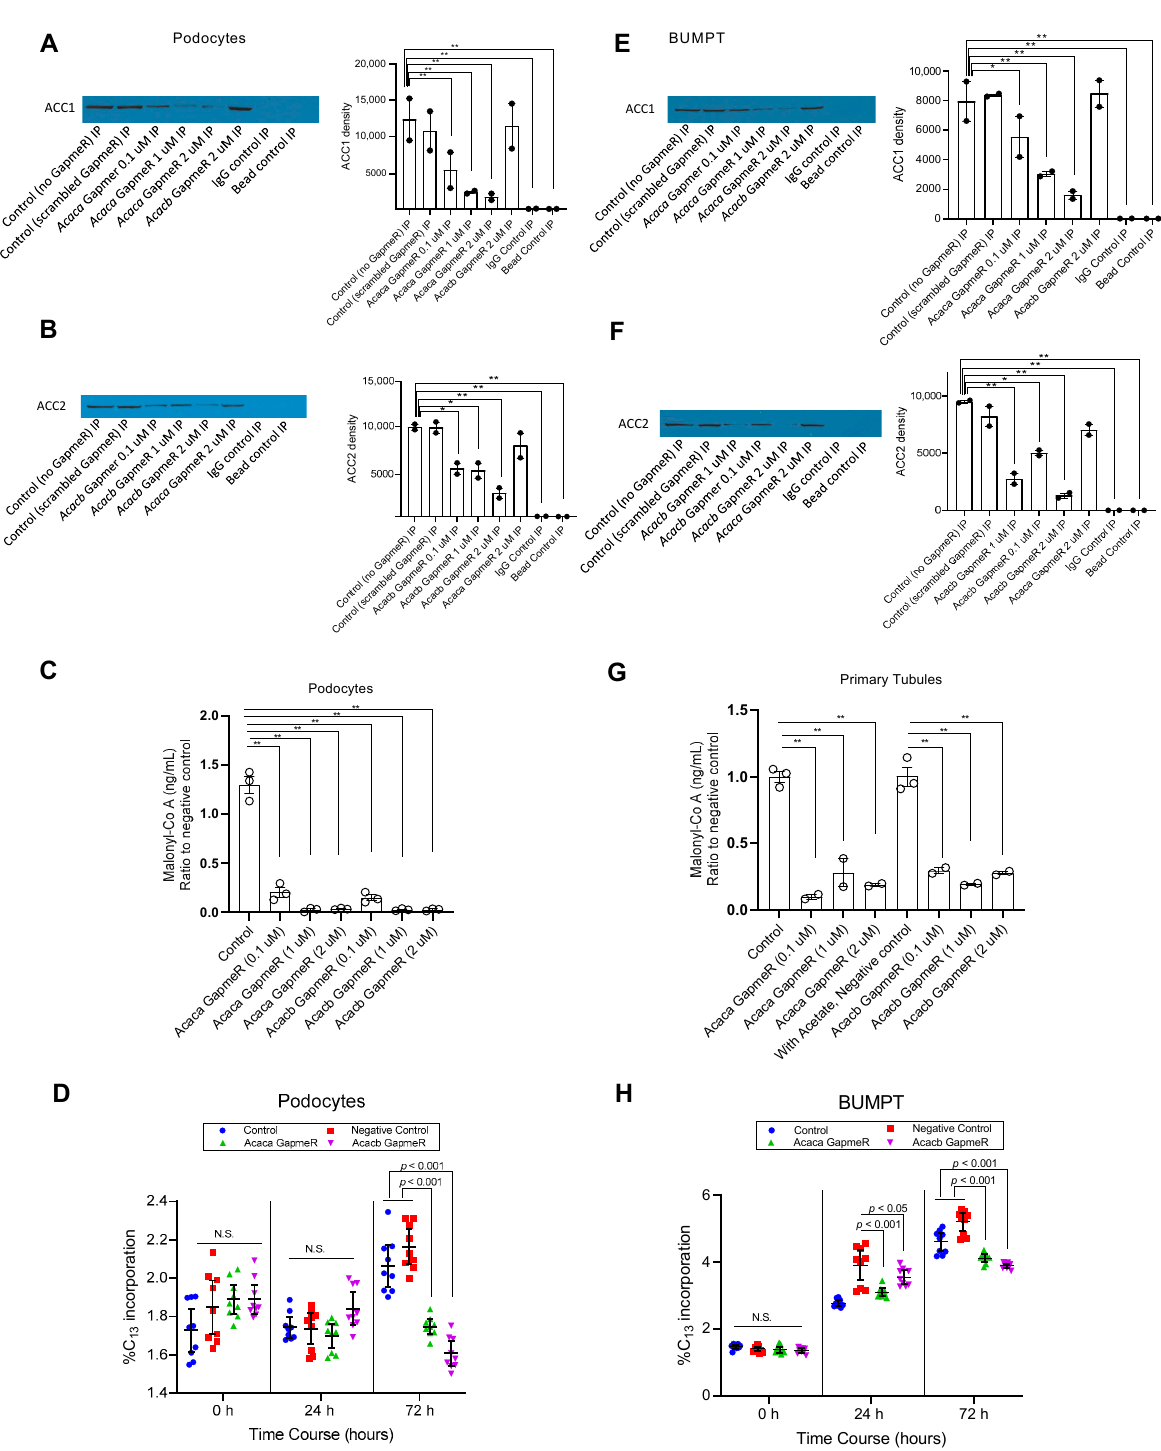
Figure 4. Down regulation of glycemic mediated DNL by Acaca and Acacb GapmeRs in podocytes and primary tubular epithelial cells in vitro: Measurement of protein expression by immunoprecipitation showed that Acaca-specific GapmeR decreased expression of ACC1 protein in a dose-dependent manner in podocytes ( A ) and primary tubular epithelial cells ( E ) compared to control cells. Acacb-specific GapmeR decreased expression of ACC2 protein in a dose-dependent manner in podocytes ( B ) and primary tubular epithelial cells compared to control cells ( F ). In ( A , B , E , F ) positive loading controls are cells with no exposure to GapmeR and cells with exposure to scrambled gapmeR. The negative controls are IgG and Bead controls. Exposure to GapmeR showed a dose-dependent suppression